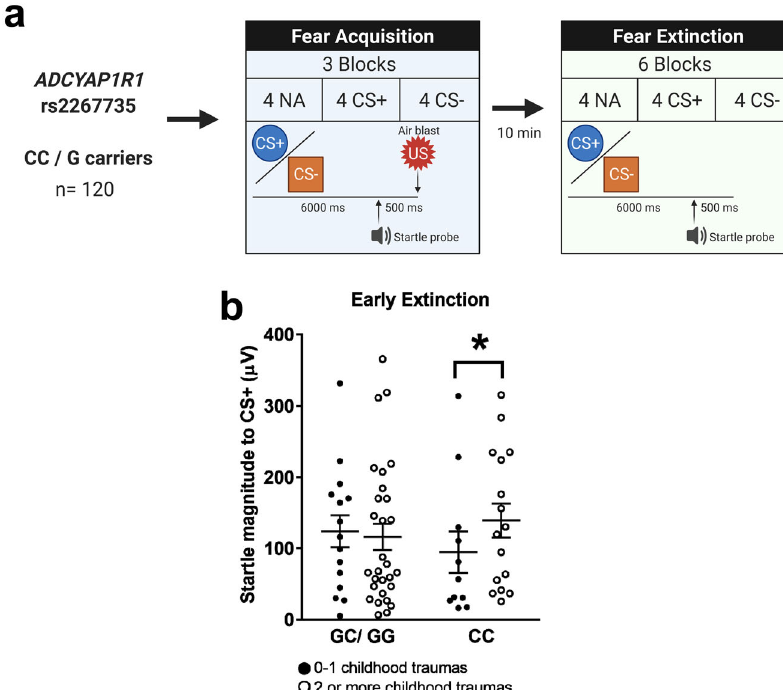
Fig. 7 ADCYAP1R1 rs2267735 genotype effects during early FE in highly traumatized individuals. a Methods used for the assessment of the in fl uence of rs2267735 genotype over FE ( n = 71, 49). b Fear-potentiated startle magnitude of cycling women ( ≤ 40 years old) with CC or GC/GG genotypes during early FE and its relation to childhood trauma exposure ( n = 71) ( P = 0.030). Analyses for >40 years old ( n = 49) are shown in Supplementary Fig. 9c. Data are means± SEM. * P ≤ 0.05. Fear-potentiated startle data in b were analyzed with an ANCOVA with extinction as repeated measures variable, age, genotype, and childhood trauma as between-subjects variables. Covariates included GWAS principal components, total lifetime trauma, baseline startle. None of the CS + presentations was paired with an US during the FE phase. CS + reinforced conditioned stimulus, CS- non-reinforced conditioned stimulus, NA noise probe alone, US unconditioned stimulus. Source data are provided as a Source Data fi